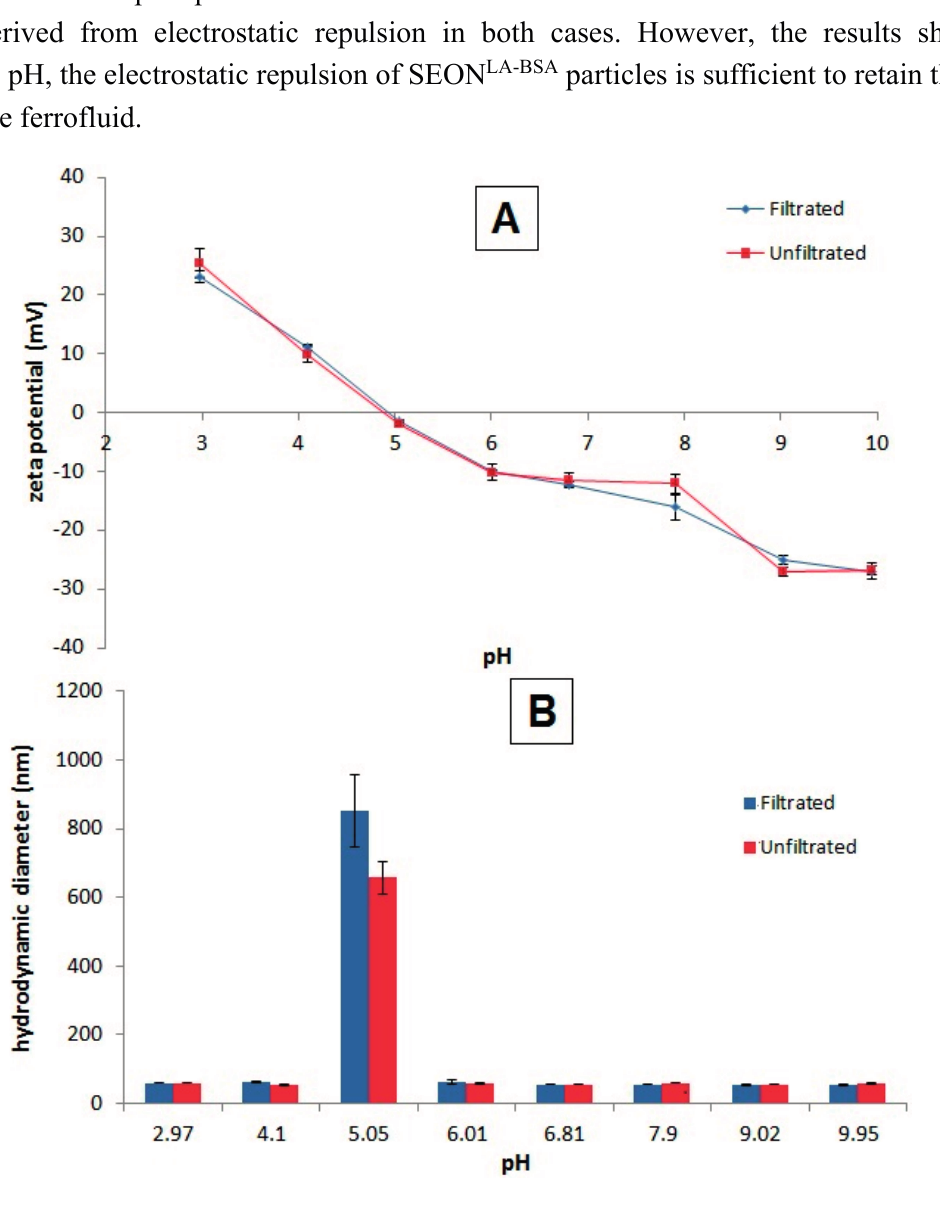
Figure 3. pH-dependent zeta potential and hydrodynamic size measurements. The development of ( A ) the zeta potential and ( B ) the hydrodynamic diameter (z-average) depending on the pH as measured by DLS. SEON LA-BSA before filtration is depicted in red; SEON LA-BSA after filtration with a double excess volume of ultrapure water is depicted in blue. All measurements were performed in triplicate 30 s after